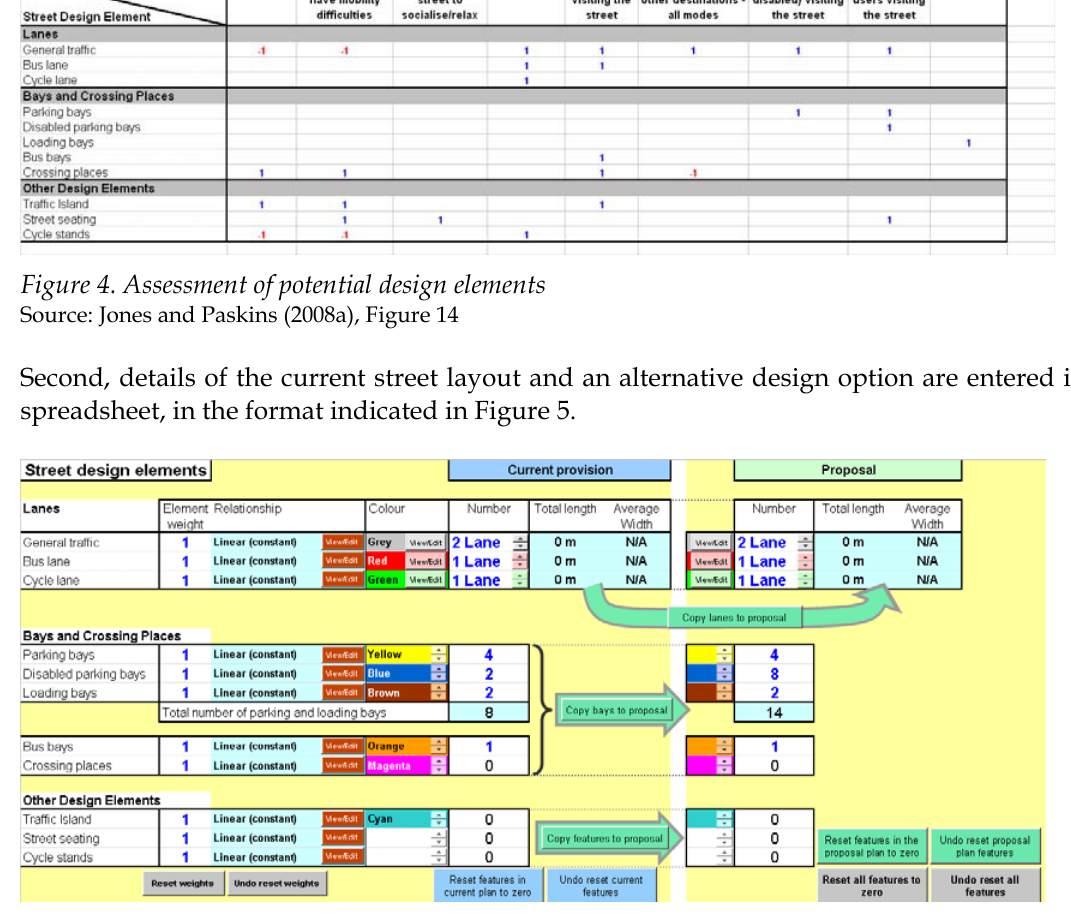
Figure 5. Details of the current and alternative street layouts Source: Extracted from Jones and Paskins (2008a), Figure